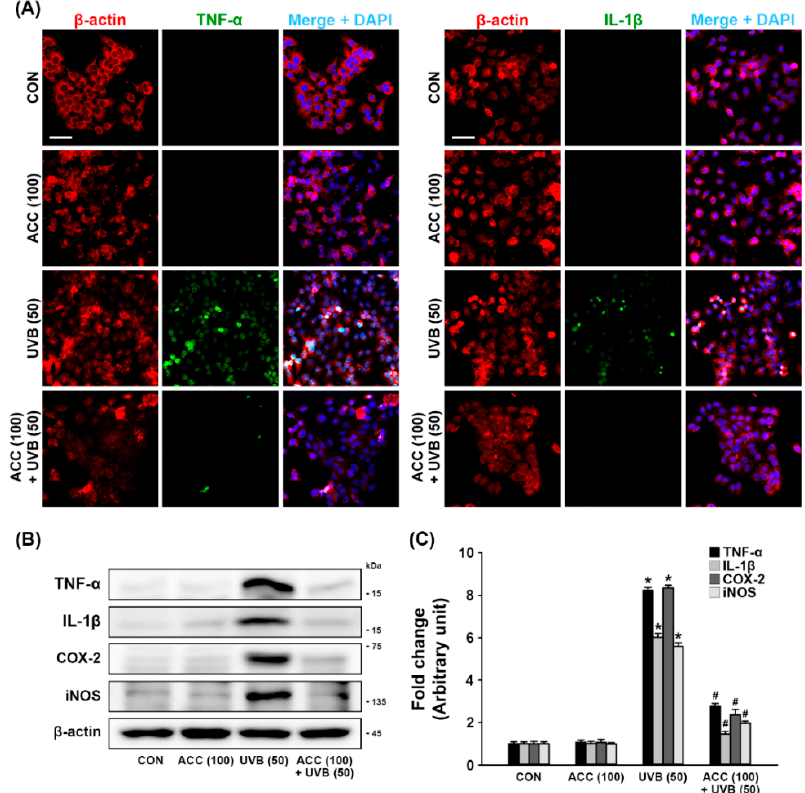
Figure 5. Anti-inflammatory e ff ect of ACC in UVB-irradiated HaCaT cells. ( A ) Representative images of immunofluorescence labeling for β -actin ( red ) and tumor necrosis factor-alpha (TNF- α ) ( green ) or β -actin and IL-1 β ( green ) in UVB-irradiated (50 mJ / cm 2 ) HaCaT cells. Scale bar, 50 µ m. ( B , C ) E ff ects of TNF- α , interleukin-1 beta (IL-1 β ), cyclooxygenase 2 (COX-2), and inducible nitric oxide synthases (iNOS) in UVB-irradiated (50 mJ / cm 2 ) HaCaT cells. TNF- α , IL-1 β , COX-2, and iNOS were measured at 1 day after UVB in HaCaT cells. * p < 0.001 vs. CON; # p < 0.001 vs. UVB (50). All experiments were repeated at least three times, and similar results were obtained.